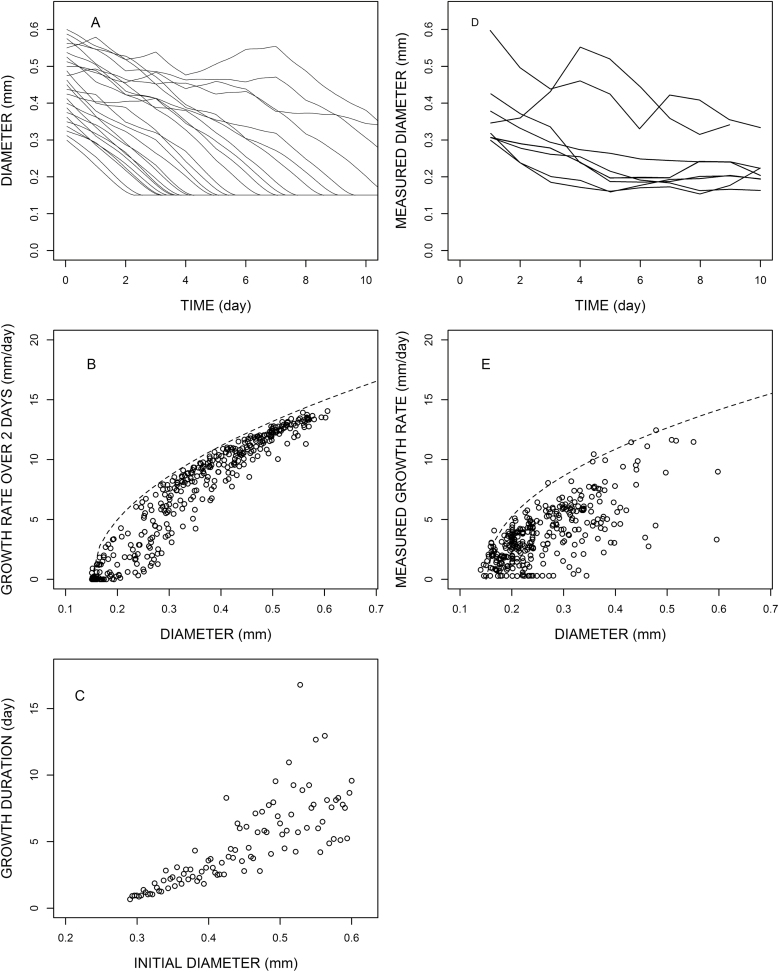
Simulation of emergent properties (A, B, C) and comparison with experimental data obtained on oak tree (D and E, redrawn from Pagès, 1995). Root parameters are: dmin=0.13 mm, dmax=1.8 mm, e= –0.55, K=7 μm h–1, kel=0.36 mm h–1)